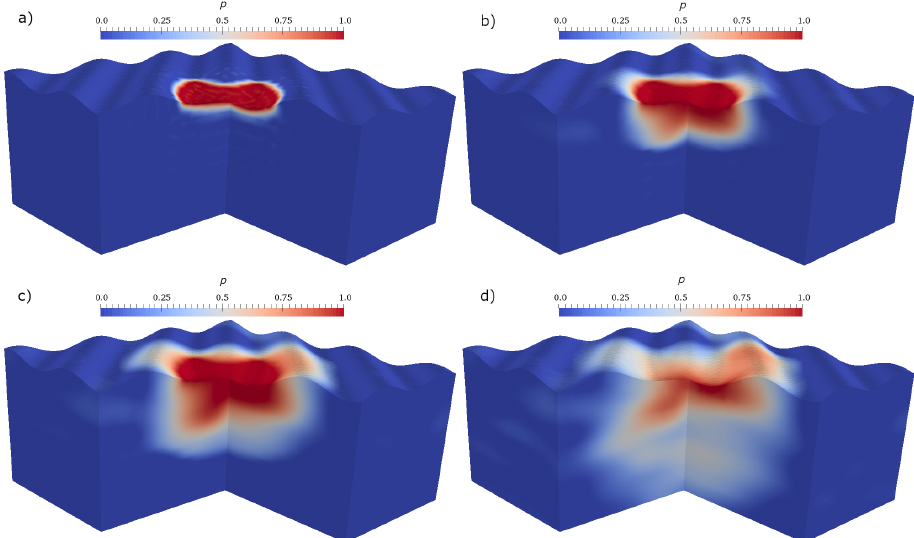
Figure 7. Numerical results for pressure that corresponds to time step: ( a ) τ = 128 ( b ) τ = 150 ( c ) τ = 200 ( d ) τ = 365. This results are coarse grid solution using 8 basis functions ( DOF c =